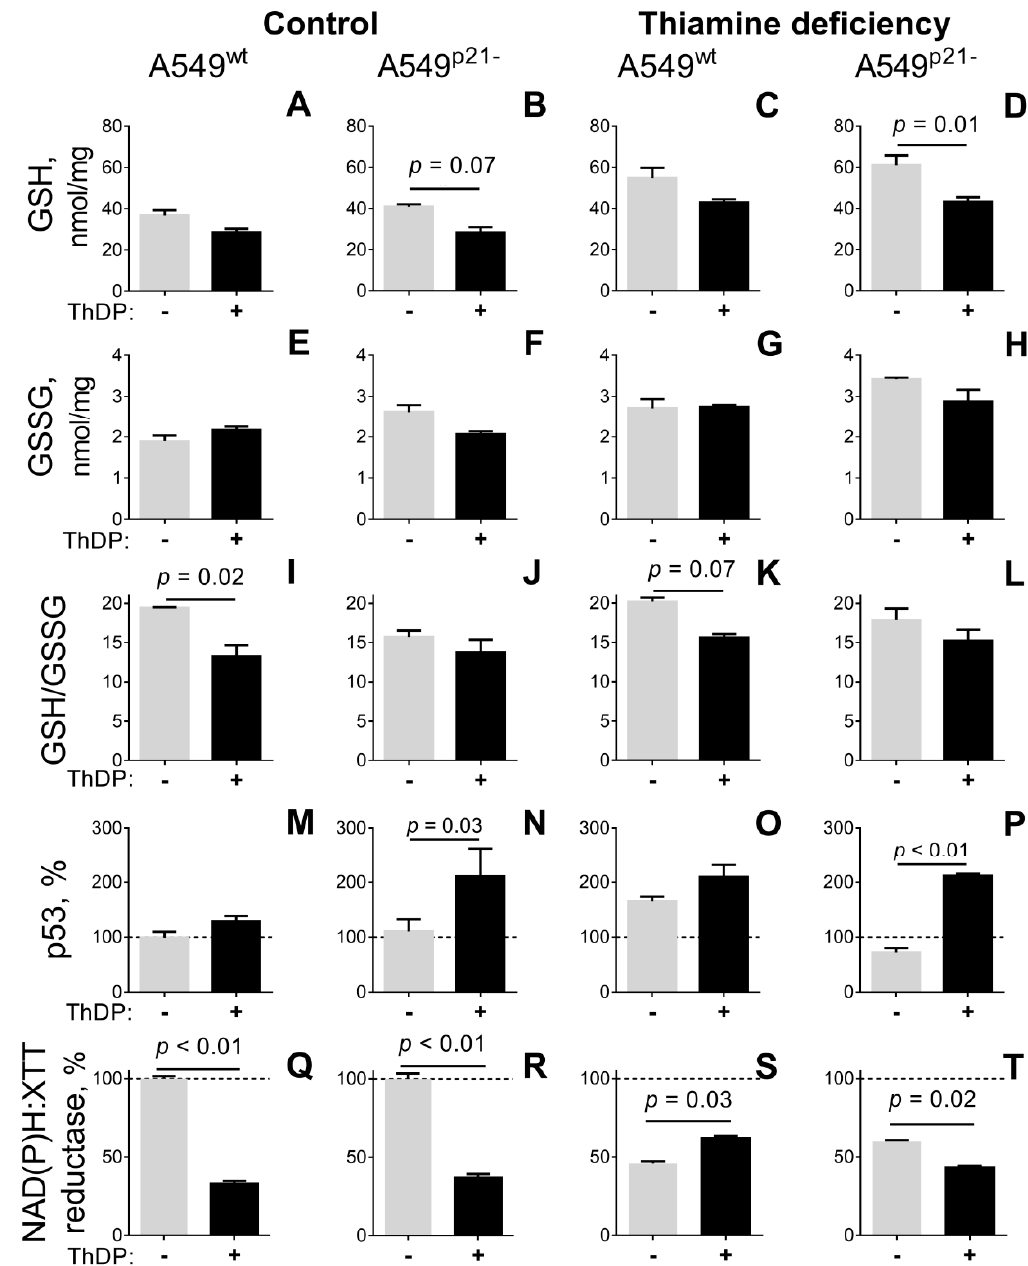
Figure 2. Influence of p21 knockdown on the thiamine / ThDP-induced changes in the levels of glutathione ( A – D ), glutathione disulfide ( E – H ), their ratio ( I – L ), p53 protein level ( M – P ) and NAD(P)H:XTT reductase activity ( Q – T ) of A549 wt and A549 p21- cells. The cells were cultured in DMEM prepared with 4 mg / L thiamine hydrochloride (Control, A, B, E, F, I, J, M, N, Q, R) or without thiamine (Thiamine deficiency, C, D, G, H, K, L, O, P, S, T). After 24 h, the media were exchanged for those without (gray columns) or with 5 mM ThDP (black columns), and the indicated parameters were assayed as described in Materials and Methods. The data of at least three independent experiments are presented as means ± SEM. On the graphs, only the statistically significant di ff erences of the ThDP e ff ects are indicated by p -values above the horizontal lines connecting the compared groups. Statistical significances of the di ff erences between all the groups are shown in Table 1. GSH—glutathione, GSSG—glutathione disulfide.